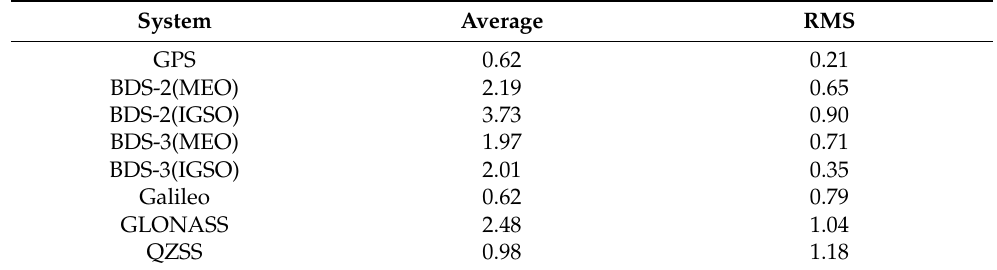
Table 5. The average accuracy and RMS of DOY 283–289 SISRE for Multi-GNSS satellites (unit: